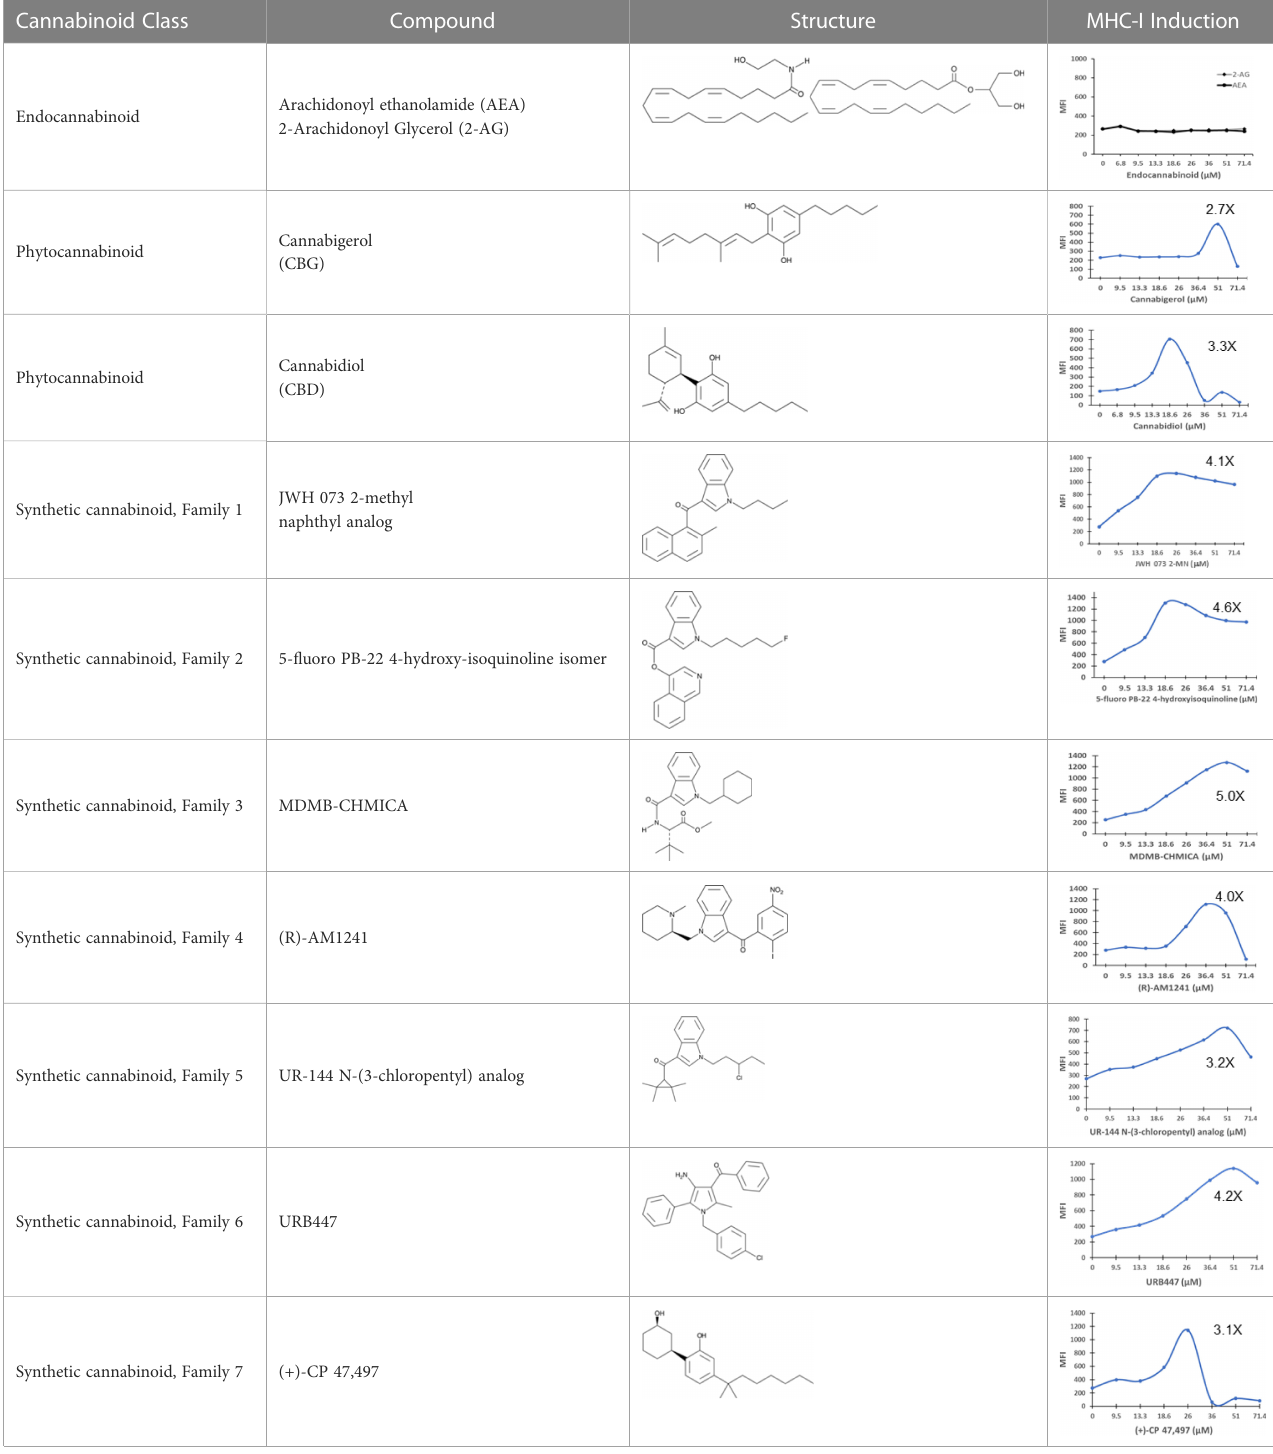
TABLE 1 Representatives of cannabinoid classes tested for induction of MHC-I expression in COLO 205 cells. Cannabinoid